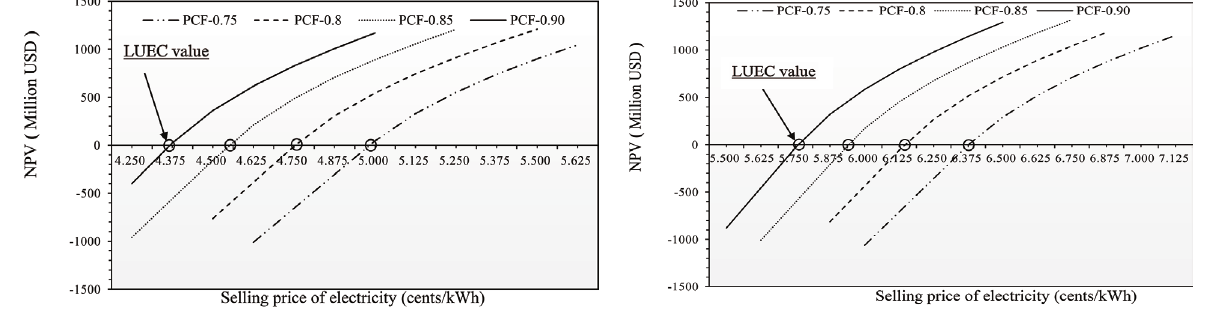
Figure 3. Variation of NPV with selling price of electricity con - sidering low O&M cost-7.82$/MWh and fuel cost-4.50$/MWh, discount rate-10%, and PCFs-75, 80, 85, and 90% (Case 1 to 4).